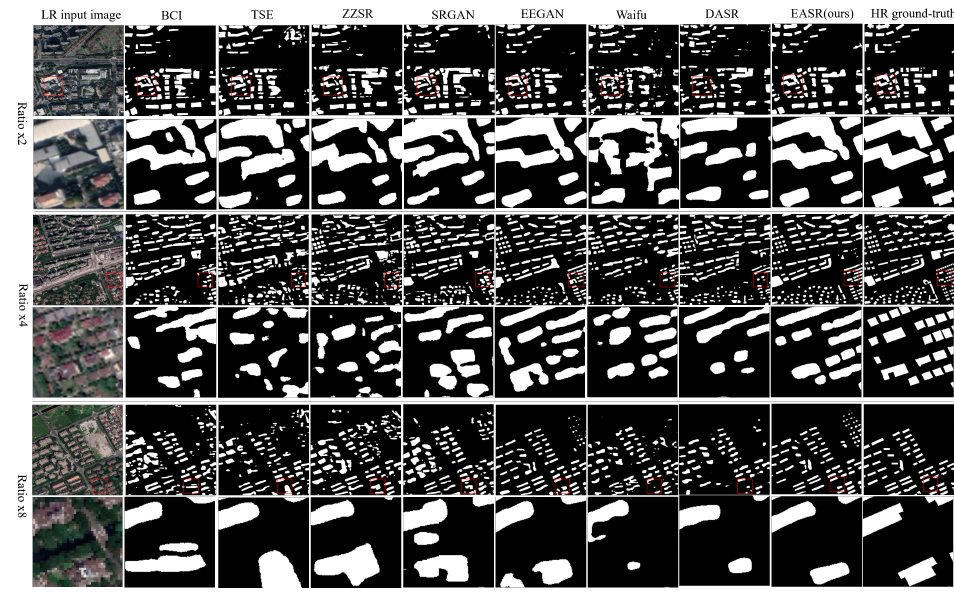
Figure 5. Qualitative examples of segmentation results of each method with ratio factors of 2, 4, and